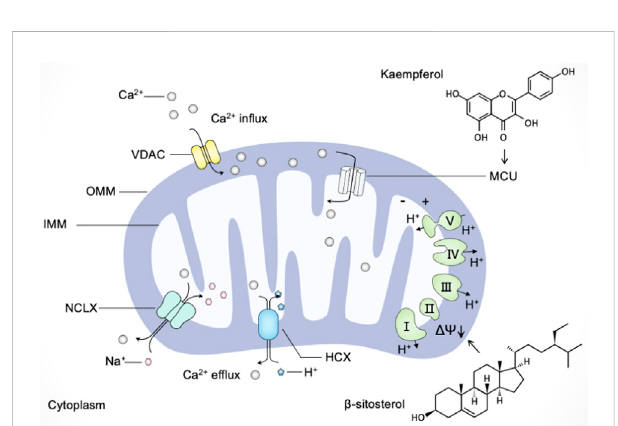
FIGURE 5 Natural products regulate mitochondria in calcium